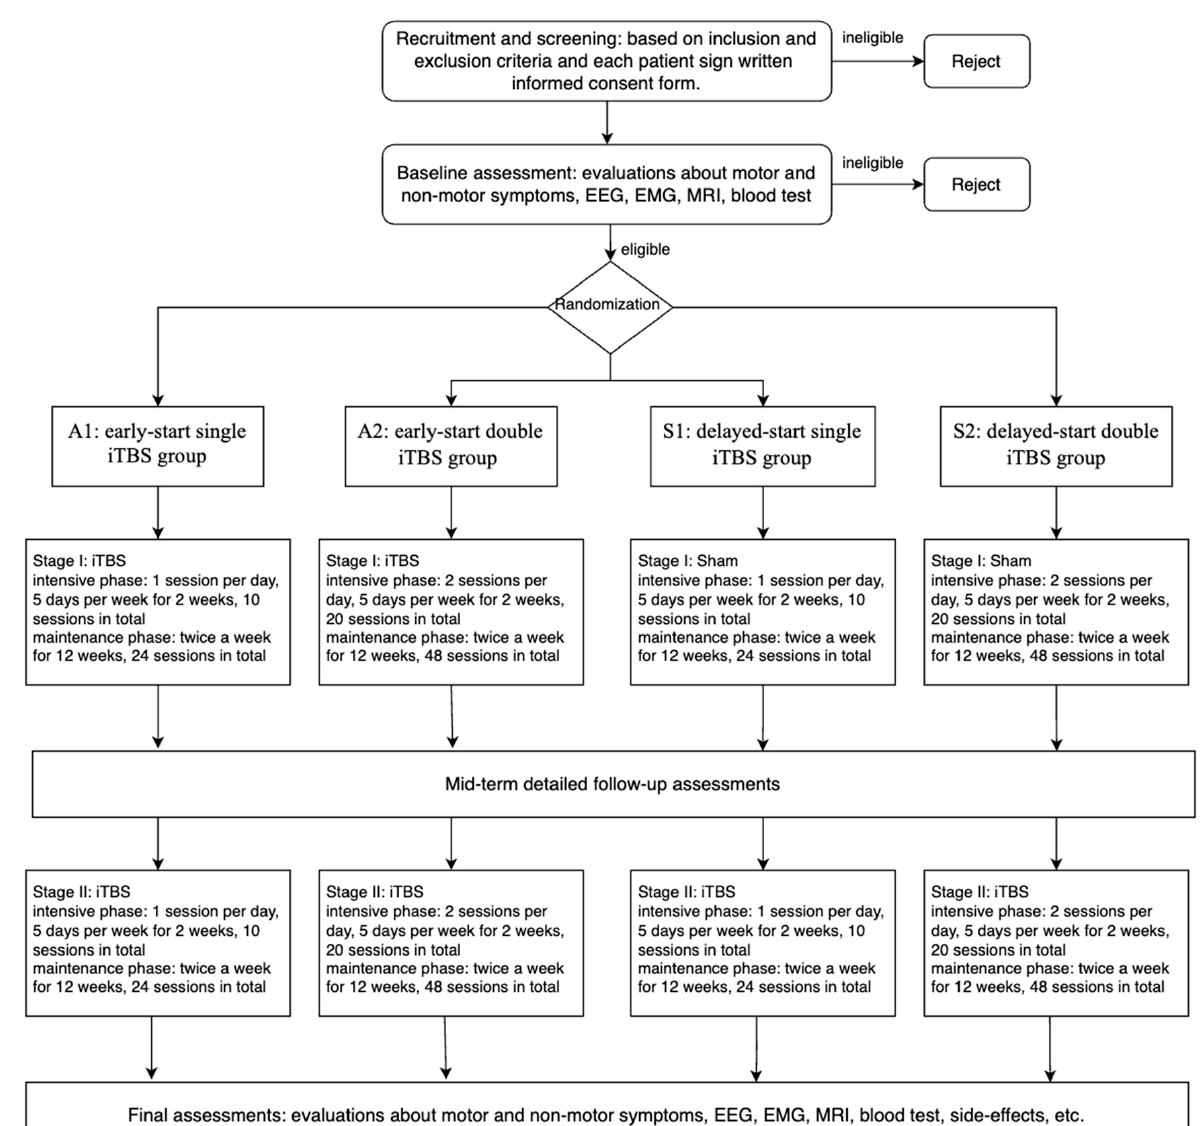
Figure 1. Schematic representation of study outline and visits. Stage 1 = pseudo-controlled stage, Stage 2 = active treatment stage; Phase 1 = intensive phase, Phase 2 = maintenance phase; A1 = early- start single iTBS group, A2 = early-start double iTBS group, S1 = delayed-start single iTBS group, S2 = delayed-start double iTBS group.